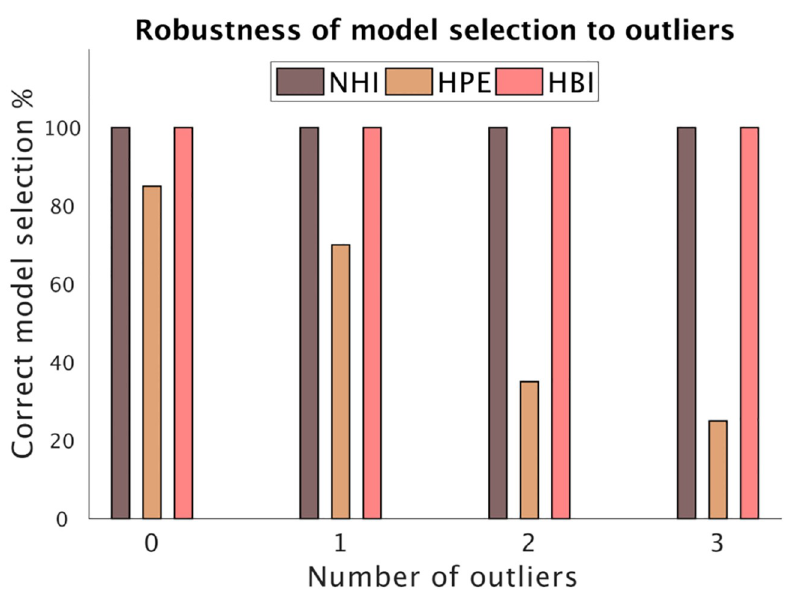
Fig 2. Robustness of model selection to outliers. The same 20 datasets simulated in the previous section were used as the base datasets (i.e. 0 outliers) and the effects of adding 1, 2 or 3 outliers to each dataset were examined. The HPE shows severe sensitivity to outliers, while the other two (random effects) methods are robust.